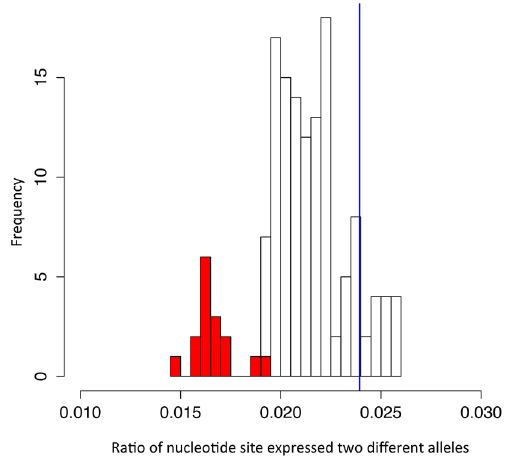
Figure 1. Estimation of the probability of RNA-Seq data from hybrid species. The bars show the distribution of ratio of nucleotide sites expressing two different alleles (mixed site). Mixed RNA-Seq samples are generated by pair-wise mixing RNA-Seq data of 16 Flaveria species, which mimics the case of hybridization. The ratio of mixed site in the mixed RNA-Seq samples is showed in grey bars (positive control). The ratio of mixed site of 16 Flaveria species is showed in red bars (real causes). The ratio of hybrid sample F. pringlei *, was represented in blue vertical